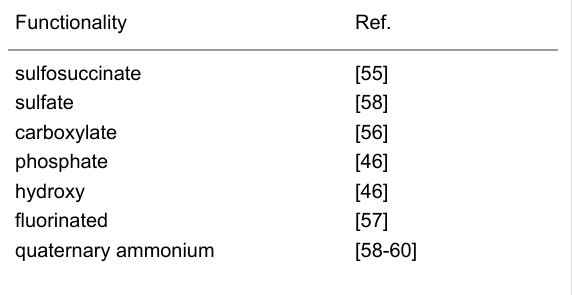
Table 4: Functionalities of polymerizable surfactants used for the stabilization miniemulsions.